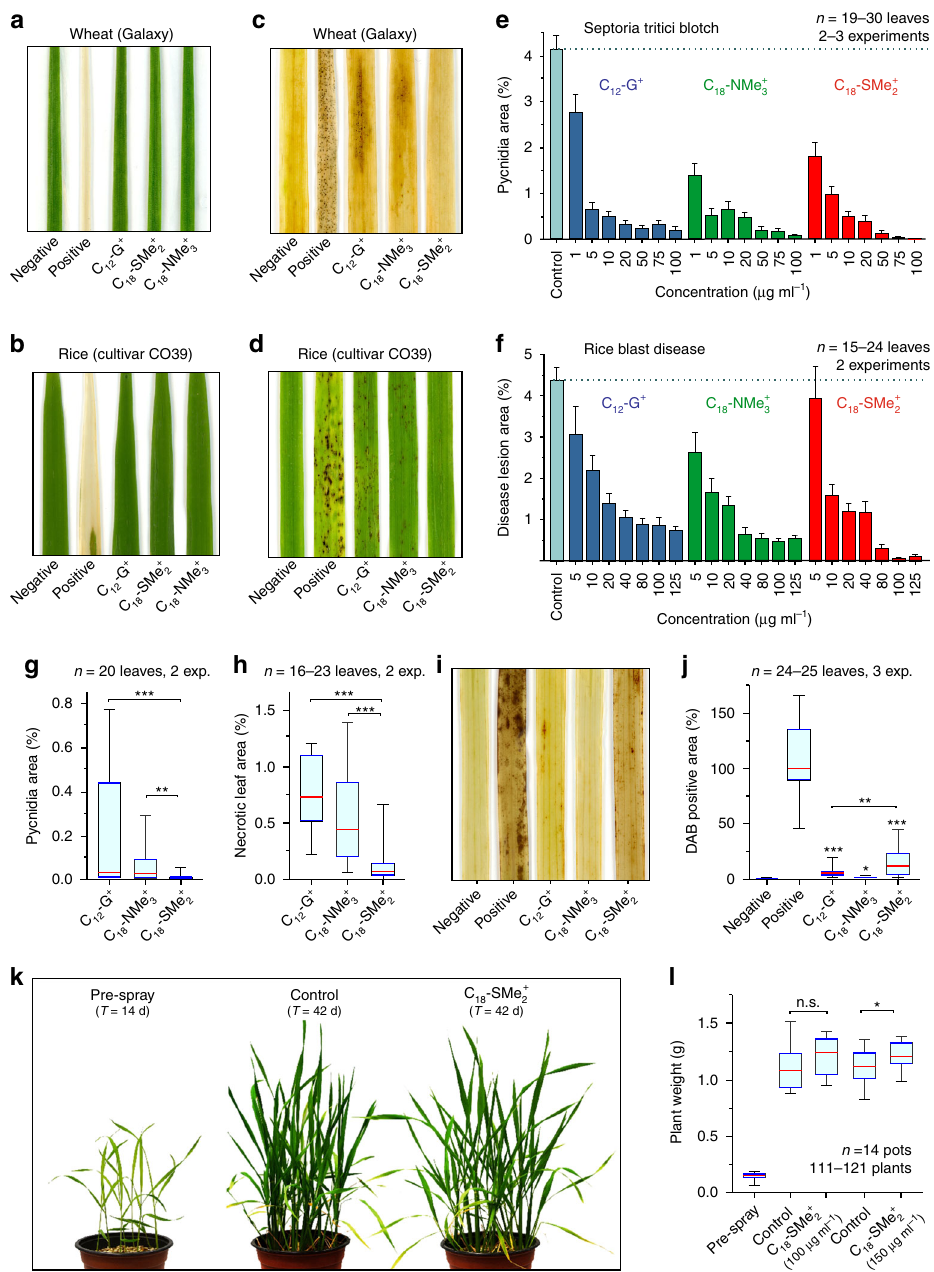
Fig. 7 Phytotoxicity and plant protection by C 12 -G + , C 18 -NMe 3 + , and C 18 -SMe 2 + in wheat and rice. a , b Phytotoxicity of C 12 -G + , C 18 -NMe 3 + , and C 18 - SMe 2 + in wheat ( a ) and rice ( b ). See also Supplementary Fig. 8a. c Septoria wheat blotch disease symptoms on wheat leaves, pre-treated with C 12 -G + , C 18 - NMe 3 + , and C 18 -SMe 2 + . Dark spots represent melanised pycnidia. See also Supplementary Fig. 8b. d Rice blast disease symptoms on rice leaves. Dark areas represent necrotic lesions. See also Supplementary Fig. 8b. e Disease symptoms in wheat after treatment with various concentrations of C 12 -G + , C 18 - SMe 2 + , and C 18 -NMe 3 + . Note that C 18 -SMe 2 + provides greatest protection against fungal infection. f Disease symptoms in rice after treatment with various concentrations of C 12 -G + , C 18 -SMe 2 + , and C 18 -NMe 3 + . Note that C 18 -SMe 2 + provides greatest protection against fungal infection. g Comparison of disease symptoms in wheat, pre-treated with C 12 -G + , C 18 -NMe 3 + , and C 18 -SMe 2 . h Comparison of disease symptoms in rice, pre-treated with C 12 -G + , C 18 - NMe 3 + , and C 18 -SMe 2 + . i DAB staining of rice leaves at 6 h after treatment with C 12 -G + , C 18 -NMe 3 + , and C 18 -SMe 2 + . j Quantitative comparison of DAB precipitation in rice leaves at 6 h after spraying with C 12 -G + , C 18 -NMe 3 + , and C 18 -SMe 2 + . Note that no DAB reaction was seen at 2 h after treatment. k Effect of C 18 -SMe 2 + on rice growth (Pre-spray: 14 days old; left pot), control and C 18 -SMe 2 + -treated plants: 42 days old (middle and right pot). l Fresh weight of rice plants, grown for 14 days (Pre-spray) and 42 days (Control and C 18 -SMe 2 + ). Values ( e , f ) are shown as mean ± SEM; sample sizes are indicated in graphs. g , h , j , l Whiskers ’ plots, with 25th/75th percentiles (blue lines), medians (red line), and minimum and maximum (whiskers ends). Sample size n is indicated in each panel. Non-parametric Mann – Whitney testing in ( g , h , j , l ); statistical comparisons are indicated by brackets; in absence of brackets comparison with negative control is shown; n.s. non-signi fi cant difference ( P = 0.1029) ( I ); * P = 0.0102 ( j ) and P = 0.0409 ( l ); ** P = 0.0017 ( g ) and P = 0.0052 ( j ); *** P = 0.001 ( g ) and P < 0.0001 ( h , j ). All P -values are two-tailed. See Supplementary Table 7 for experimental conditions. All source data are provided as a Source Data fi